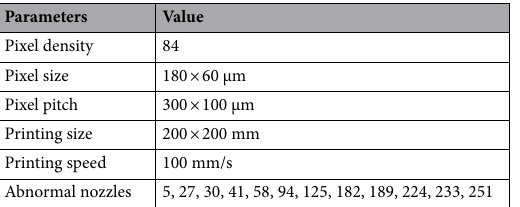
Table 3. Printing parameters for comparative printing experiments.